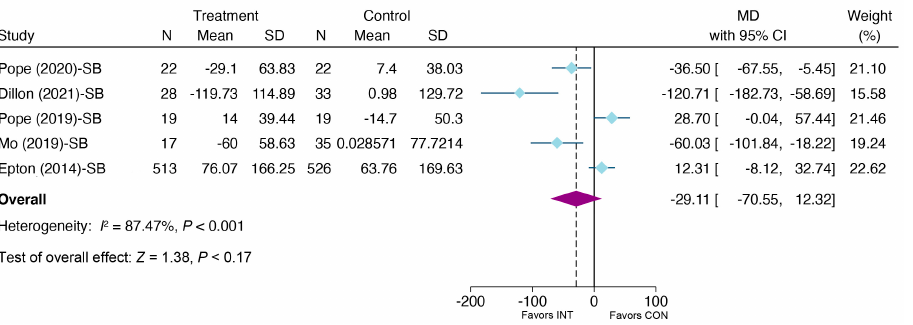
Figure 6. Meta-analysis of effects of e-health interventions on SB versus control [37,48–50,58].